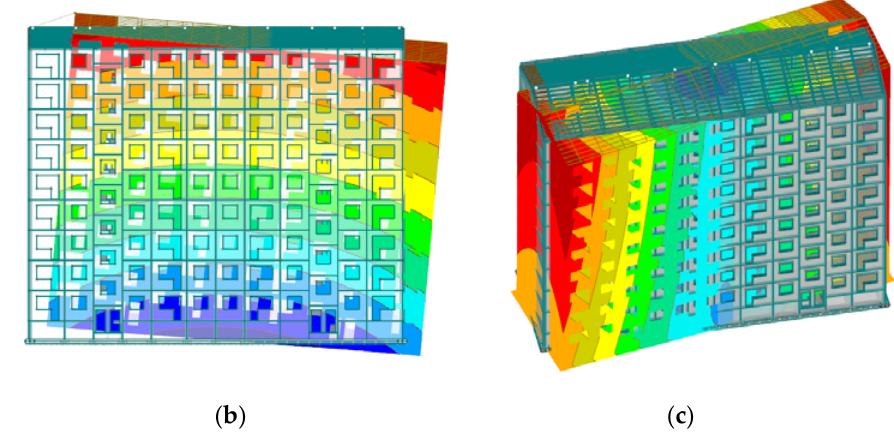
Figure 4. Fundamental vibration modes in each direction: ( a ) lateral mode; ( b ) longitudinal mode; ( c ) torsional mode. Table 7 analyzes the variation of rocking frequencies with soil type for buildings on shallow foundations. Table 7. Rocking frequency f r according to soil type.